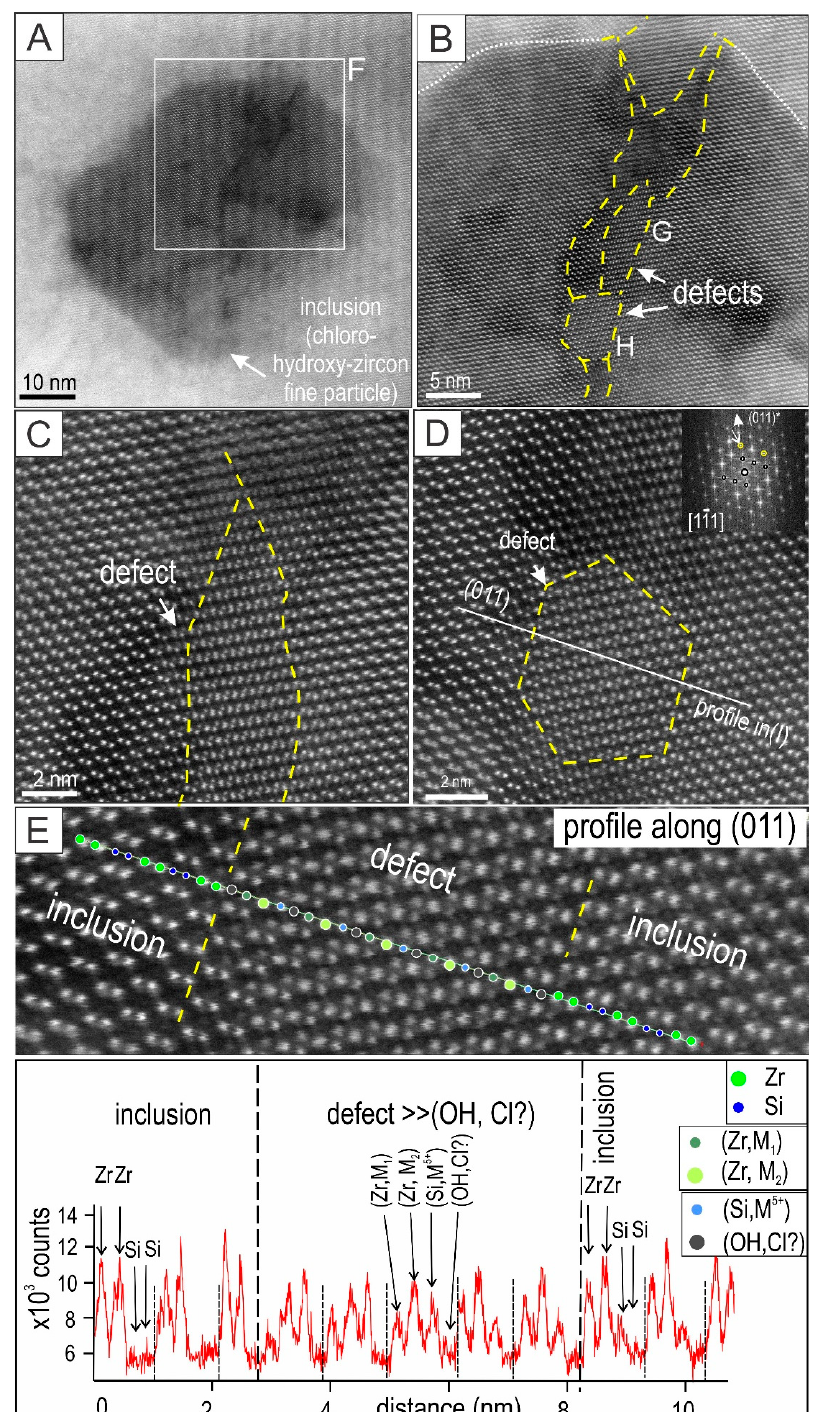
Figure 14. ( A – D ) Images showing defects along a fracture crosscutting one of the fine particles (Foil #1). The FFT pattern obtained from the image (inset D ) shows a square sub-pattern with weaker reflections superimposed onto the main reflections. Yellow, dashed lines mark the defect shape. ( E ) Intensity profile across the defect in ( D ) showing modifications in the Zr and Si signals as marked.